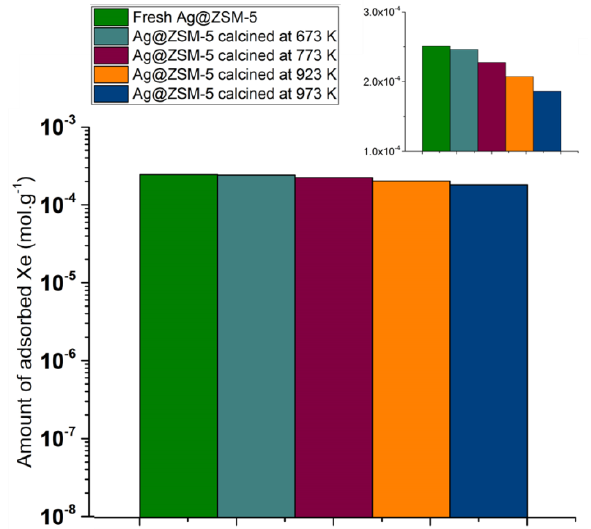
Figure 4. Xenon adsorption capacity at 5 ppm (298 K) on Ag@ZSM-5 calcined at several temperatures (from 623 K to 973 K). Y-axis in a log scale; (insert) zoom with linear scale.